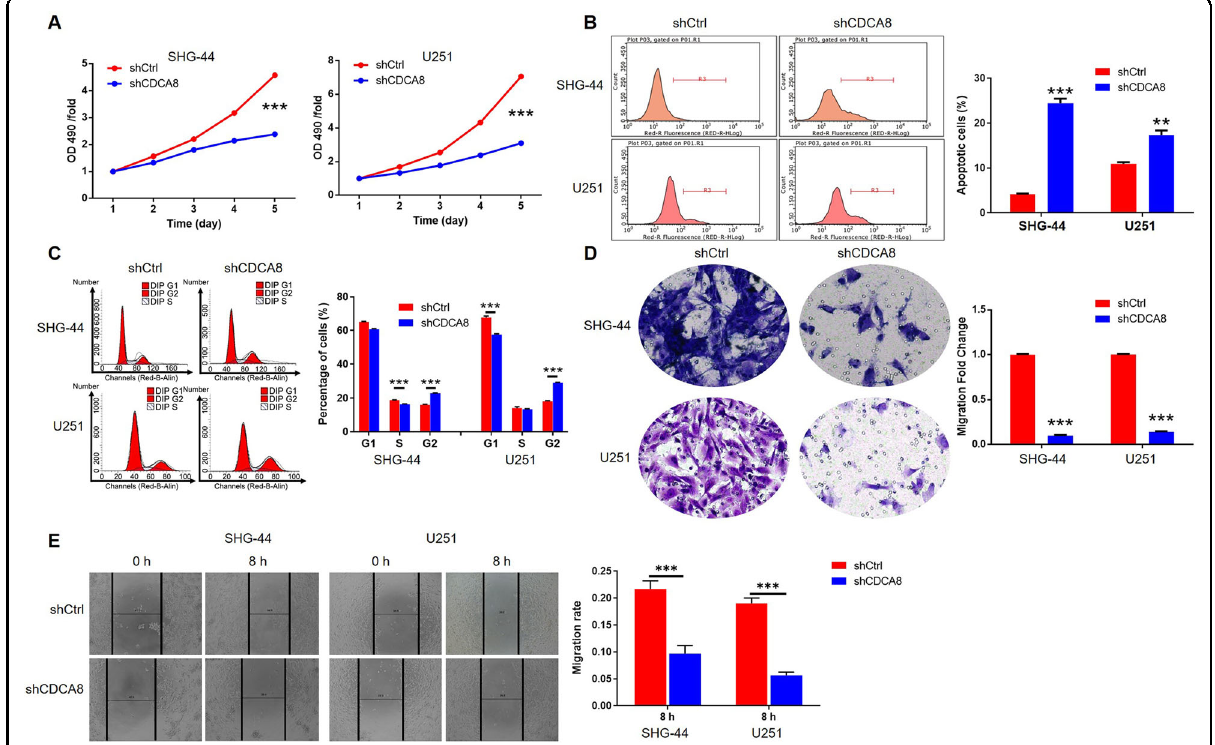
Fig. 2 CDCA8 promotes glioma cell proliferation and migration in vitro. A The effects of CDCA8 knockdown on SHG-44 and U251 cell proliferation in MTT assay. B , C Flow cytometry of cell apoptosis ( B ) and cell cycle distribution ( C ) of SHG-44 and U251 cells infected with shCtrl or shCDCA8. D , E Transwell ( D ) and wound-healing ( E ) assays of CDCA8 knockdown on SHG-44 and U251 cells migration. The experiments were repeated three times independently, and the bars represent SD. ** P < 0.01, *** P <